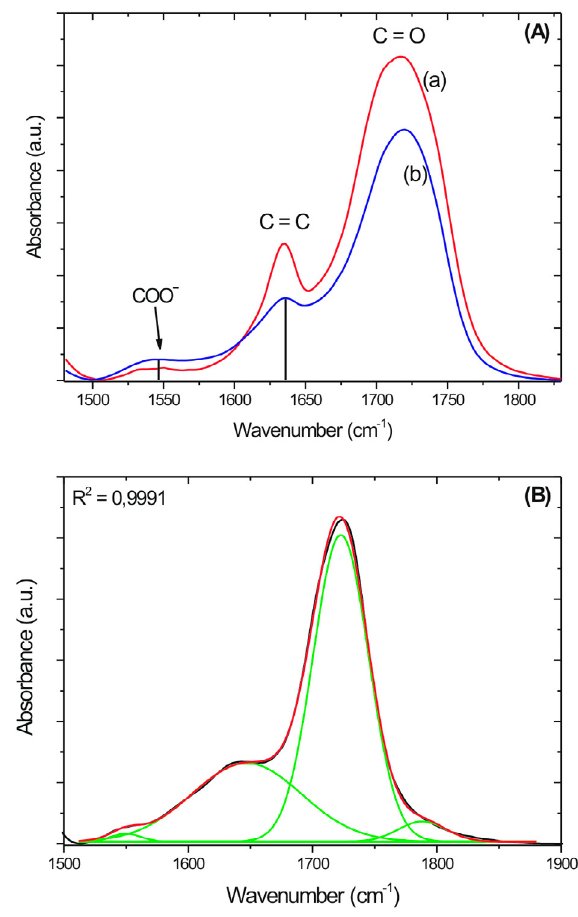
Figure 2- (A) RMGIC absorption band before (a) and after (b) polymerization; (B) Fit of the RMGIC+CaGP spectrum, buth in the region from 1500 to 1850 cm -1 . The green lins in (B) represent four gaussian shapes and the red line their sum, which give the best fit to the experimental spectrum (black